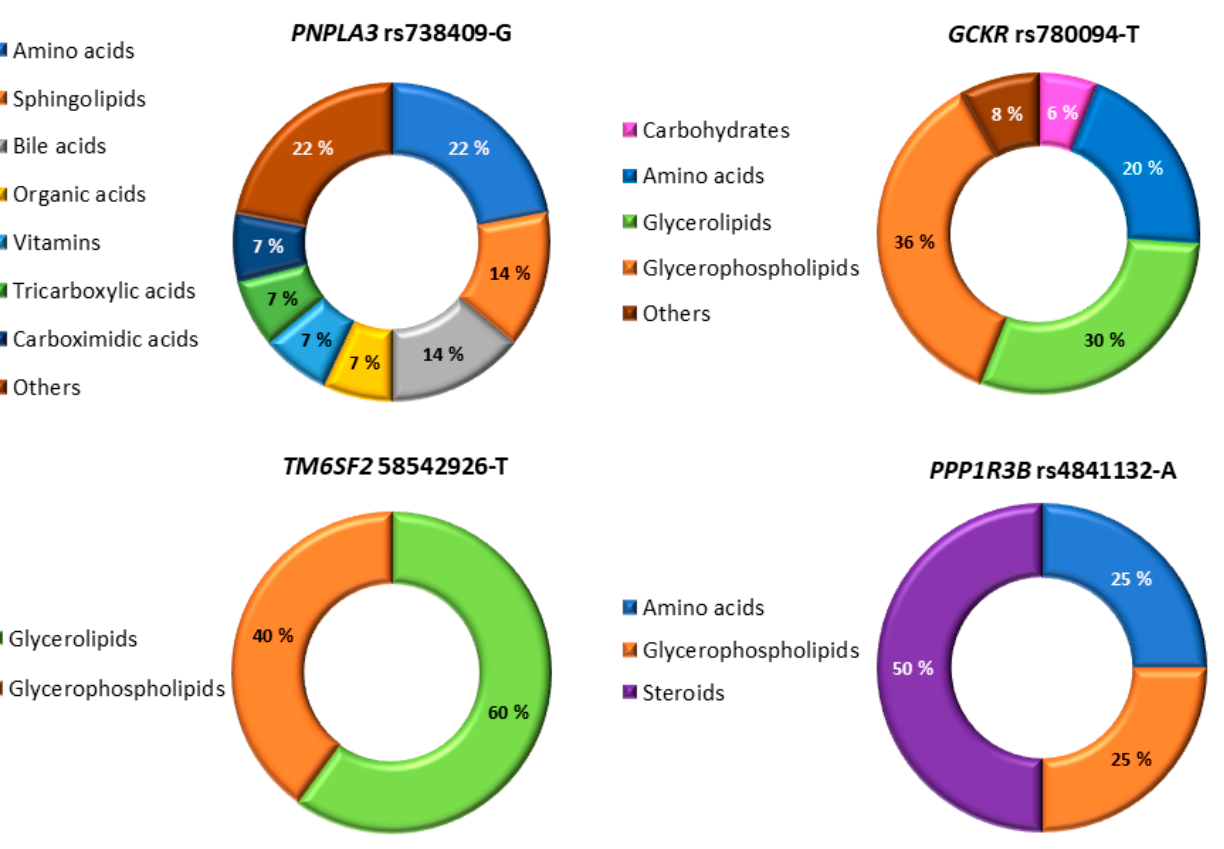
Figure 1. Metabolite subgroups associated with four genetic variants in men with NAFLD.